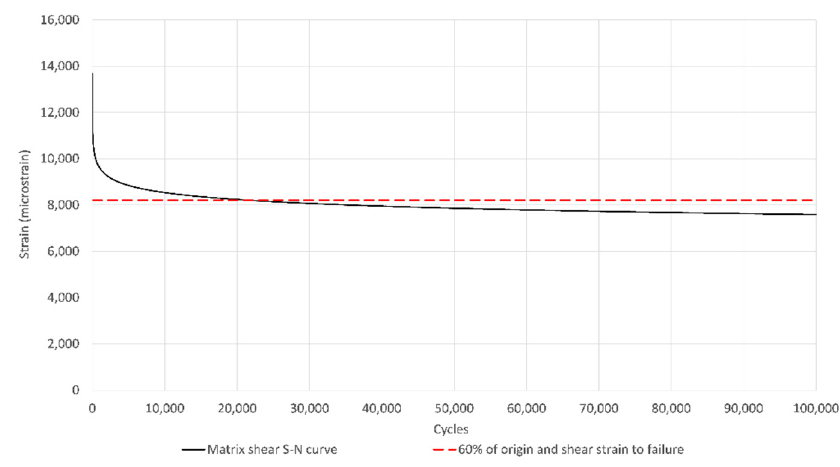
Figure 8. S-N curve for the matrix shear plotted against the reduction factor on the delamination properties. See the Material Properties section for further information on the S-N curve.